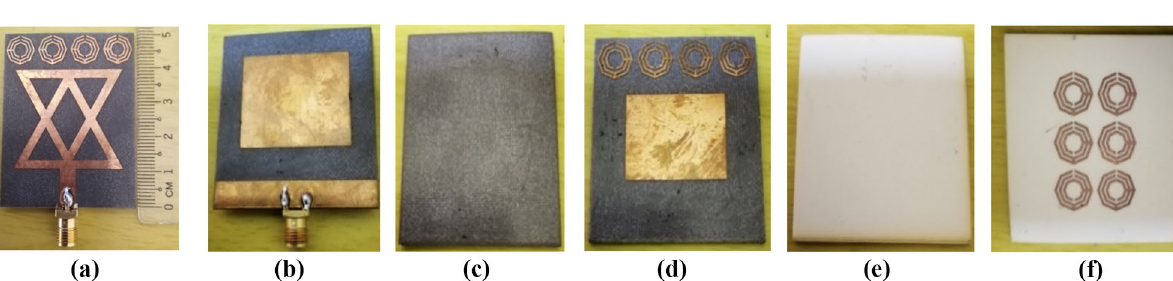
Figure 6. Simulated reflection coefficient of parametric analysis: ( a ) Variations of the air gaps between layers; ( b ) Variation of length of the ground plane; ( c ) Variations of the MTM array elements in the BL.